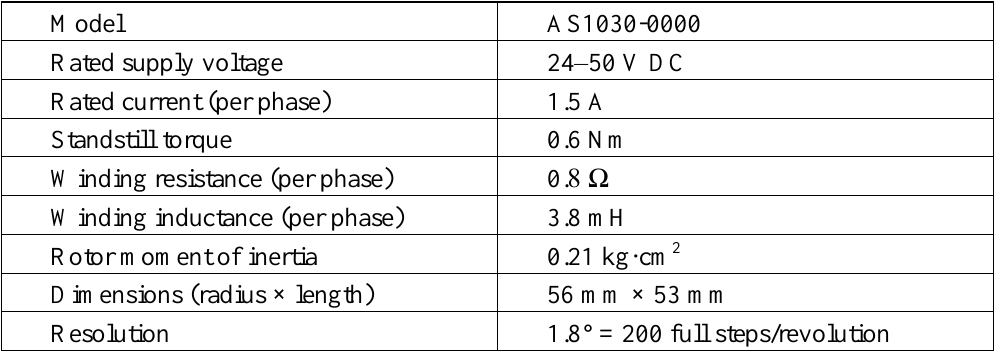
Table 1. Datasheet of the AS1030-0000 stepper motor by Beckhoff Automation GmbH, Verl, Germany [6].